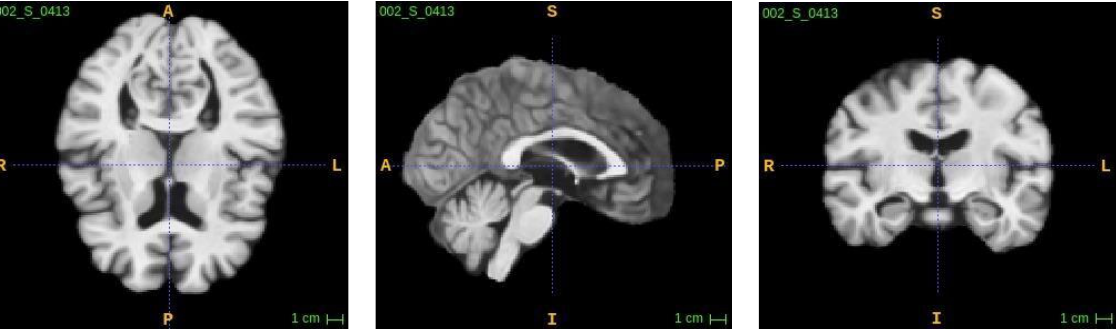
Figure 5. Axial, sagittal, and coronal views of an MRI without a skull.